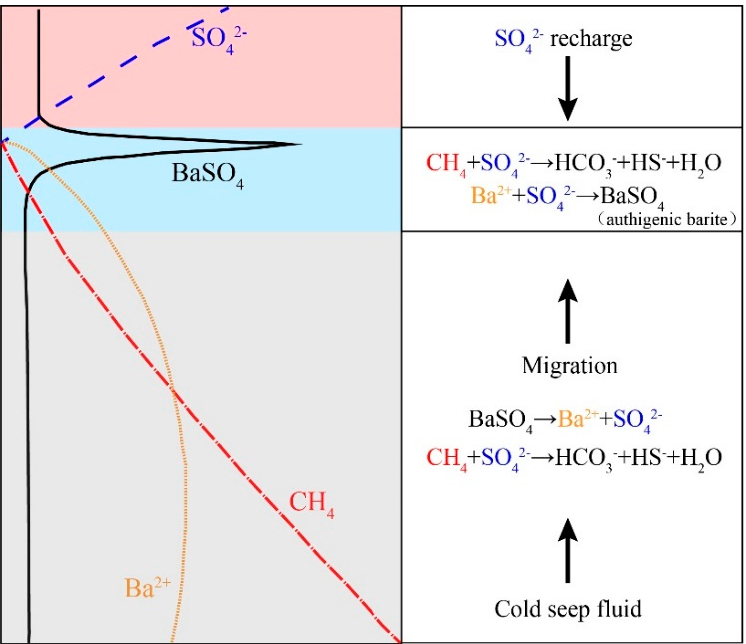
Figure 5. Main chemical reactions during the formation of barite front.